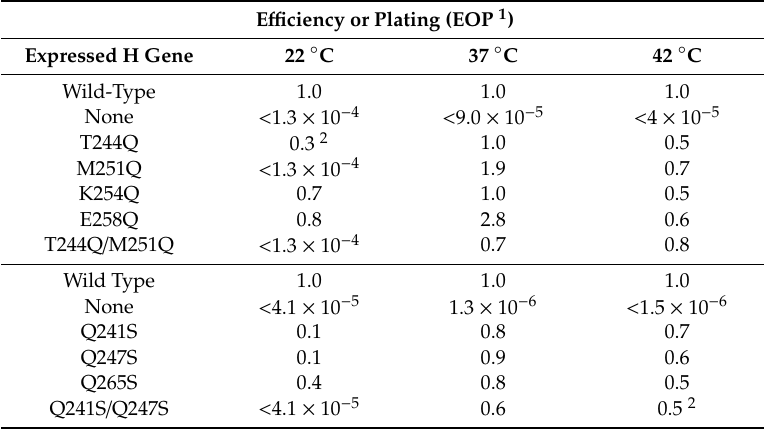
Table 2. am(H) plating e ffi ciencies on cells expressing gene H